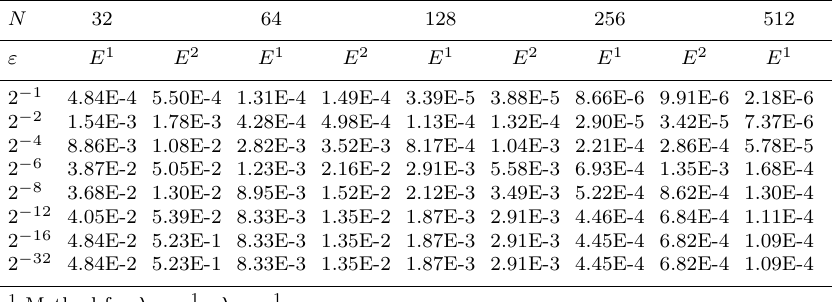
Table 1. Maximum absolute error( E ) for Example 1 with δ = 0 . 5